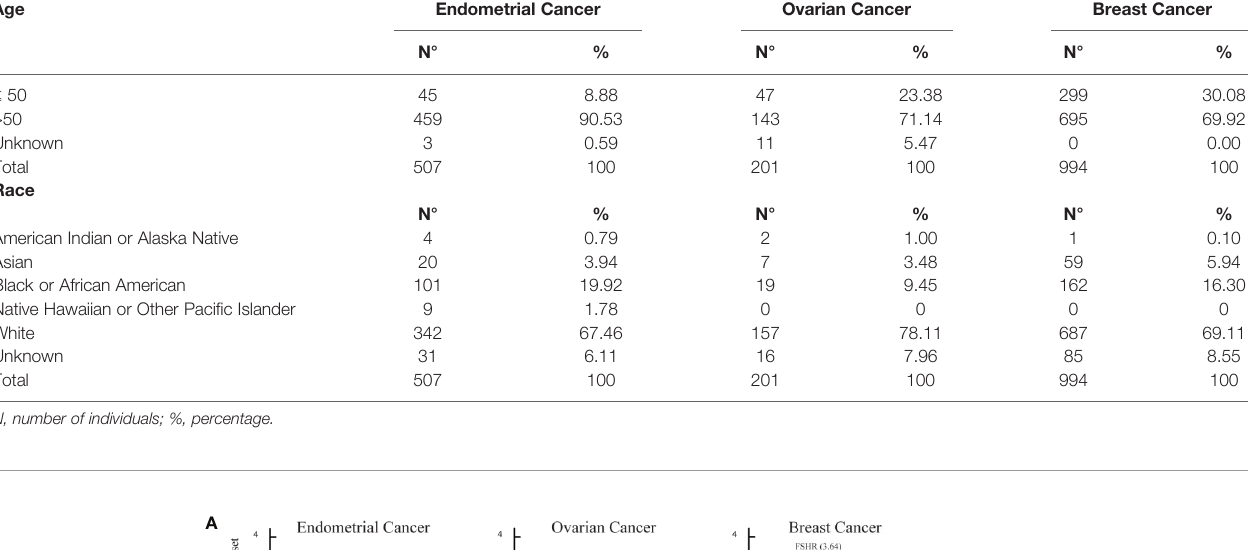
TABLE 2 | Description of the individuals for genomic alteration analysis. Age